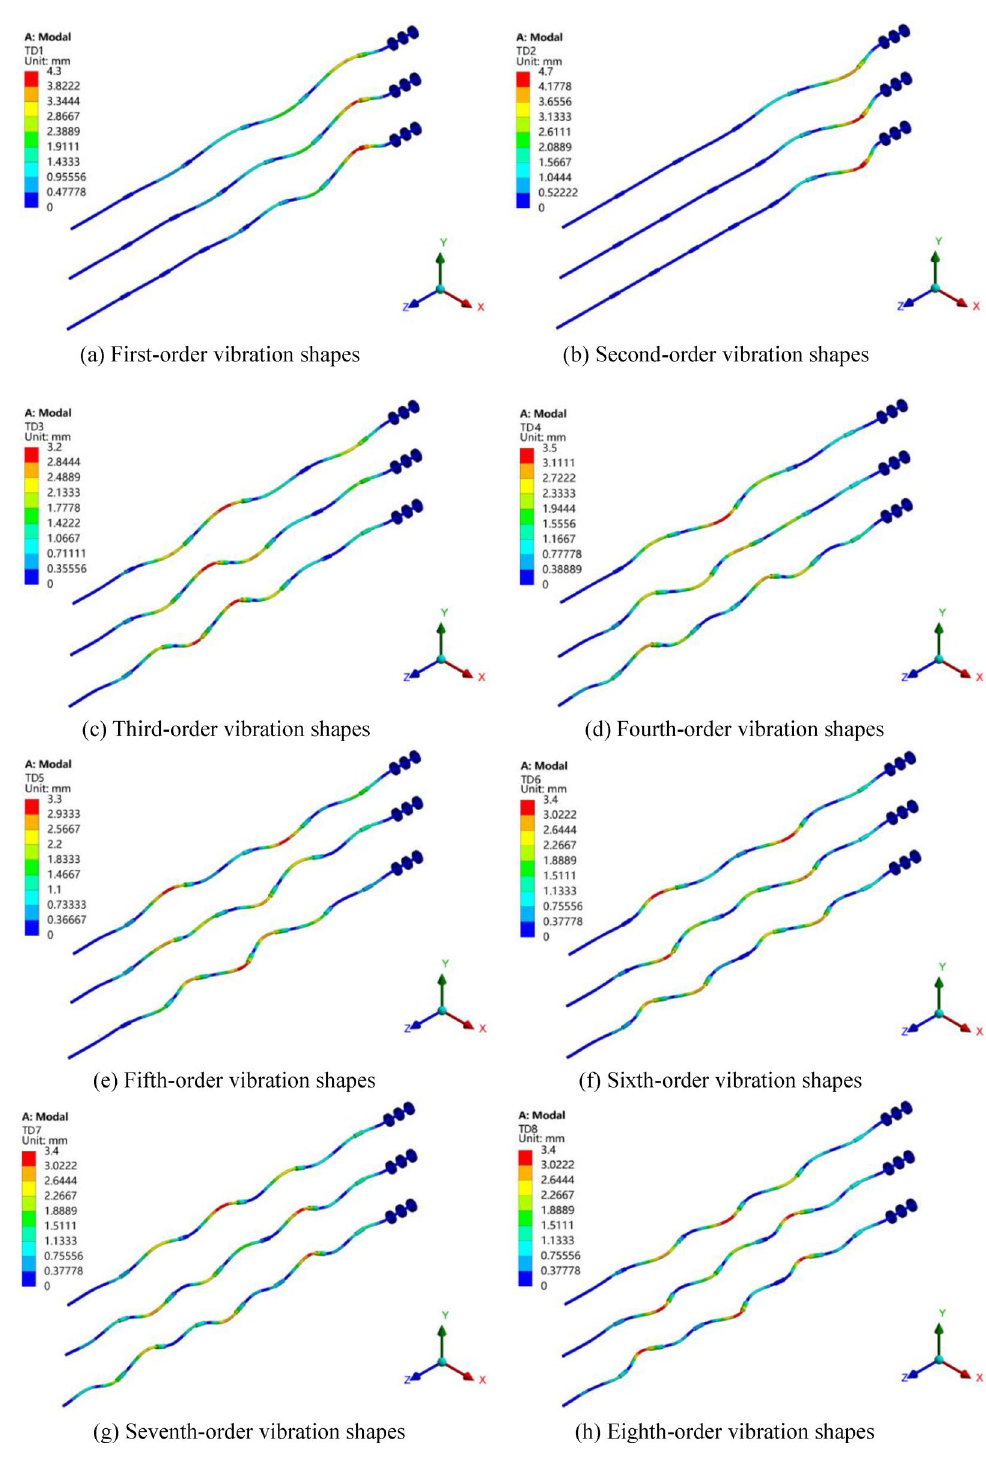
Figure 16. Vibration shapes of the three